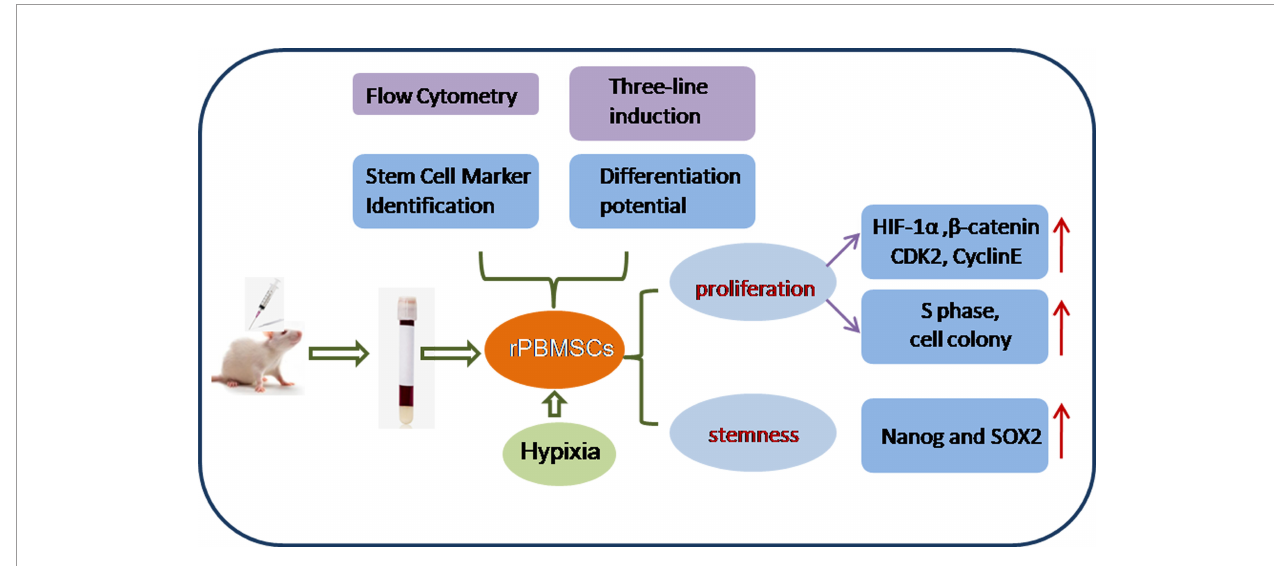
FIGURE 6 | Mechanism of hypoxia-promoted proliferation and stemness of